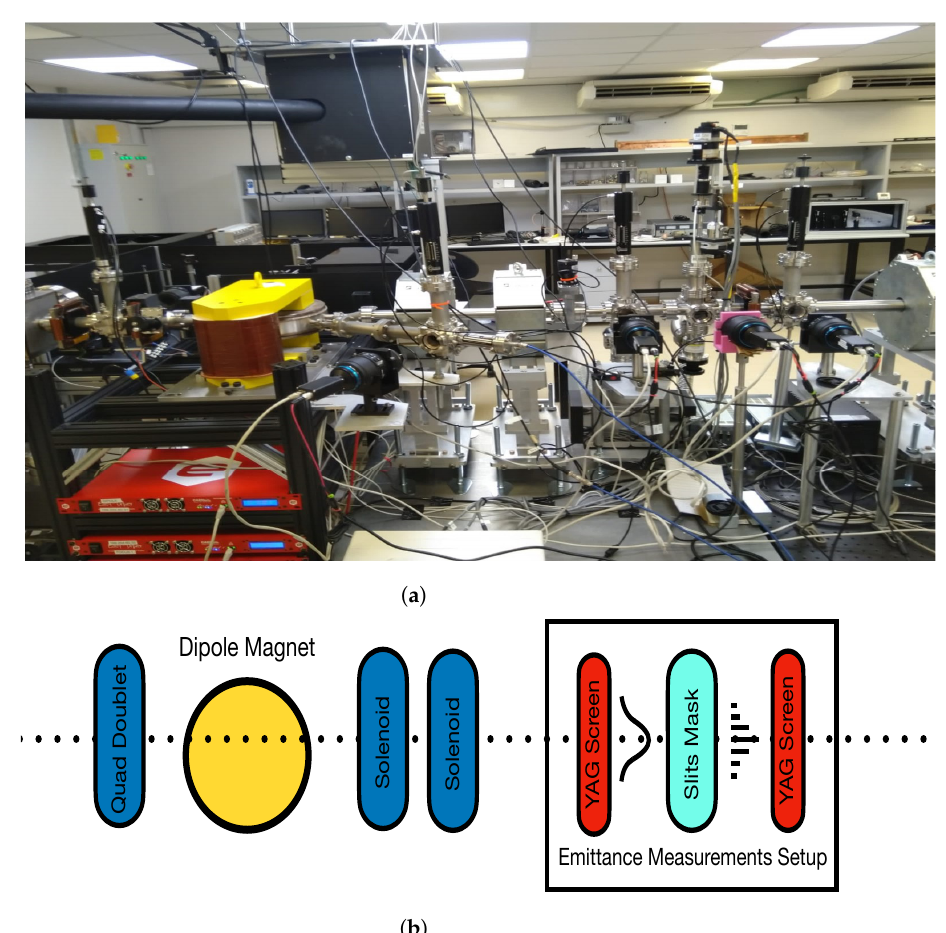
Figure 1. ( a ) Emittance measurement setup. ( b ) Scheme of ( a